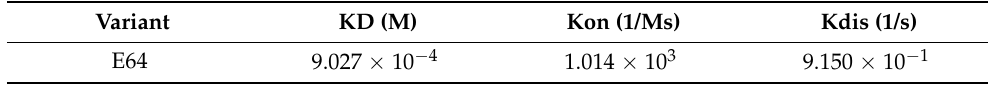
Figure 8. The affinity effect of ASFV pS273R and E64. ( A ) The biotin − ASFV S273R protein was solidified with SSA sensor with a solidifying signal of about 20 nm. ( B ) The SSA sensor immobilized with the ASFV S273R protein was subjected to binding dissociation detection with different concentrations of E64 molecules at baseline 60 s, association 60 s, and dissociation 60 s. The kinetic curves were obtained and analyzed with Octet Analysis 12.0 software to obtain the kinetic data. Table 6. The affinity of E64 for ASFV S273R.